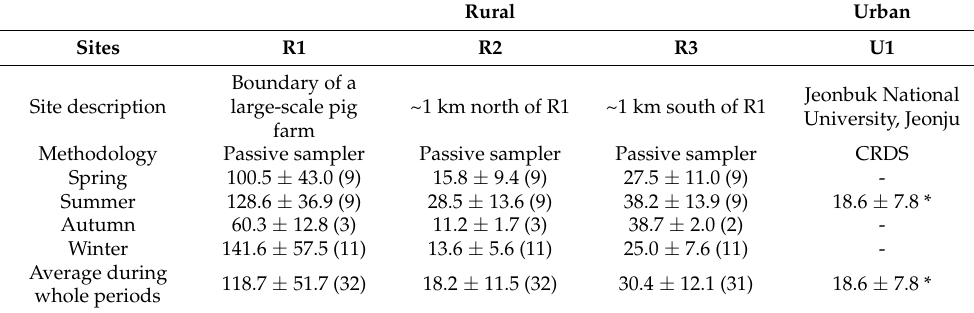
mentioned in parentheses. “-” indicates no data available. CRDS is cavity ring down